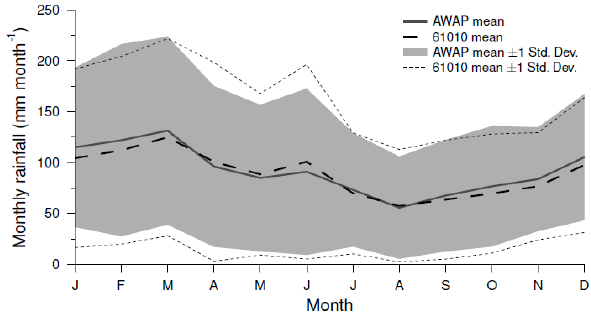
Figure 2. Climatology of WR catchment rainfall. Shown is the mean and standard deviation of monthly rainfall recorded at the 61010 gauge and for the AWAP catchment